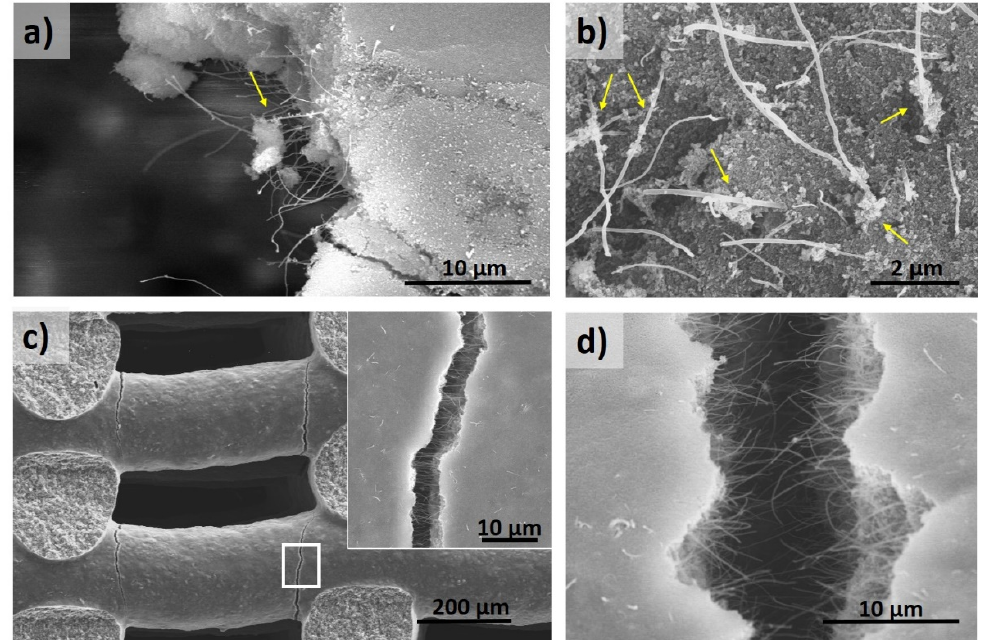
Figure 5. Micrographs of MWCNT composite structures after compression tests. ( a , b ) Pulled-out CNTs in boehmite/MWCNT composite showing boehmite particles adhered to some parts of the nanotubes. ( c ) Example of pulled-out nanotubes at cracks near α-Al 2 O 3 /MWCNT structure nodes, with nanotubes aligned in the direction parallel to the rod. ( d ) Close image of nanotubes in the Al 2 O 3 /MWCNT structure. Different from ( a ), the α-Al 2 O 3 grains are not adhered to the nanotubes.